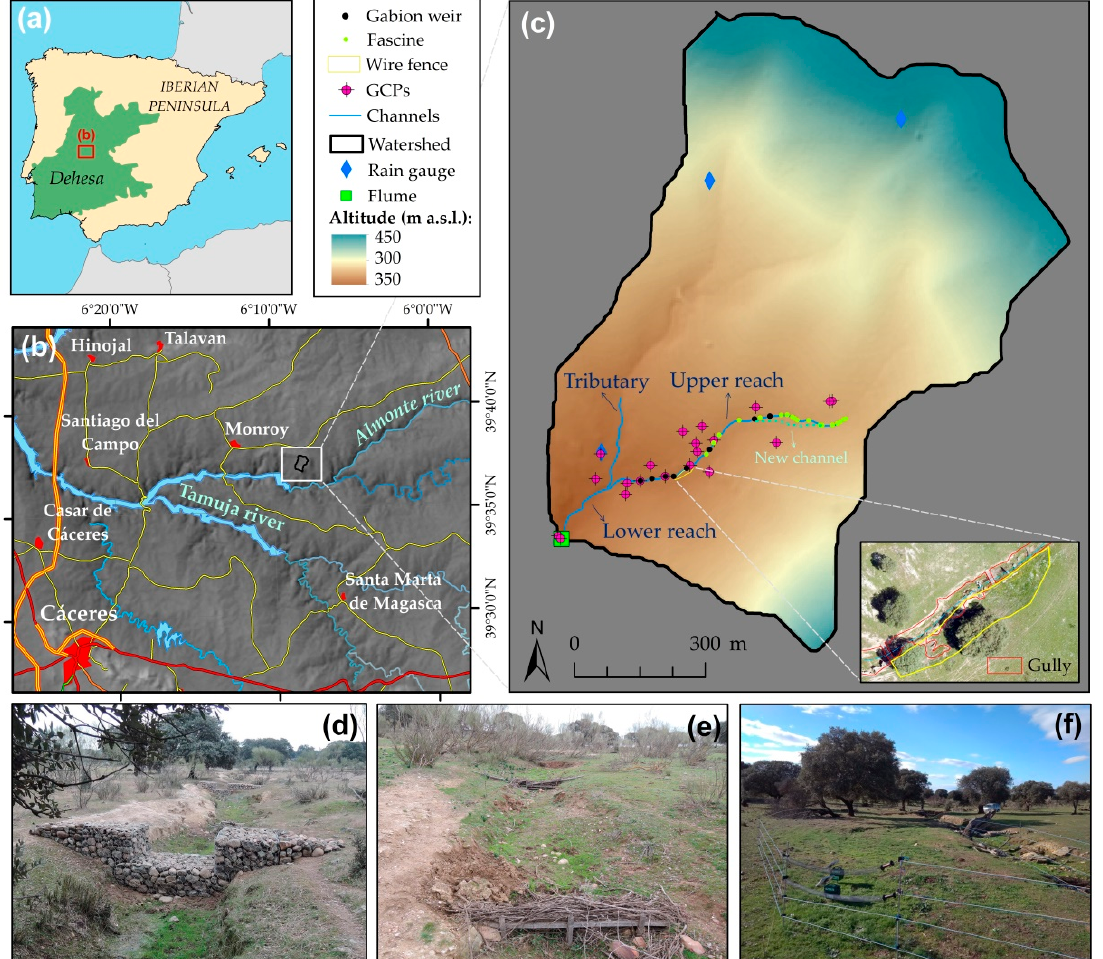
Figure 1. ( a ) Location of the study area in the Iberian Peninsula where the green area displays where dehesas are frequent and the red rectangle represents the area shown in ( b ); ( b ) regional setting of the study area where the main towns, rivers, and roads are shown over the hillshade and the white rectangle of the area shown in ( c ); ( c ) Parapuños catchment including the restoration measures carried out and the ground control points (GCPs); examples of gabion weirs ( d ), a fascine structure ( e ), and the isolated area in the left bank of the gully ( f ). Table 2. Characteristics of the surveys carried out. GSD: ground sampling distance, GCPs: ground control points, RMSE: root mean square error.